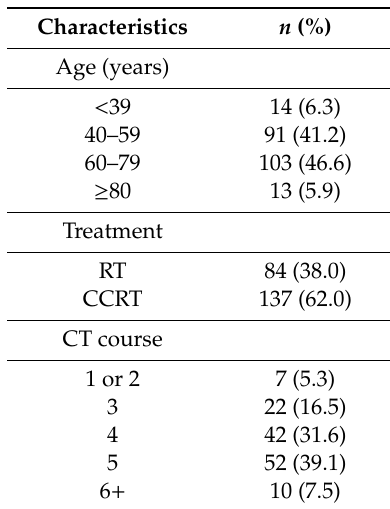
Table 1. Patient